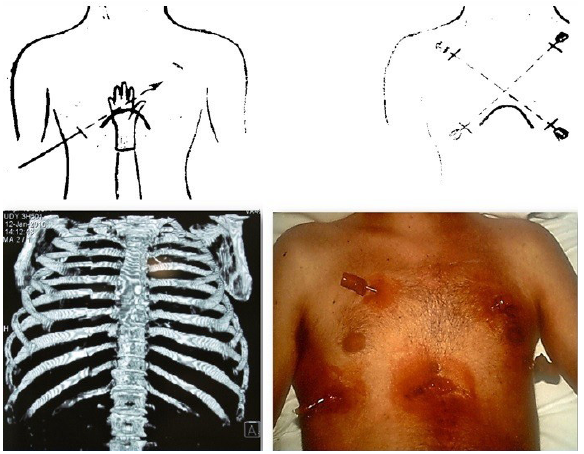
Figure 1. Surgical technique for the stabilization of the anterior flail chest with crossed Kirschner’s wires (subxiphoid access).